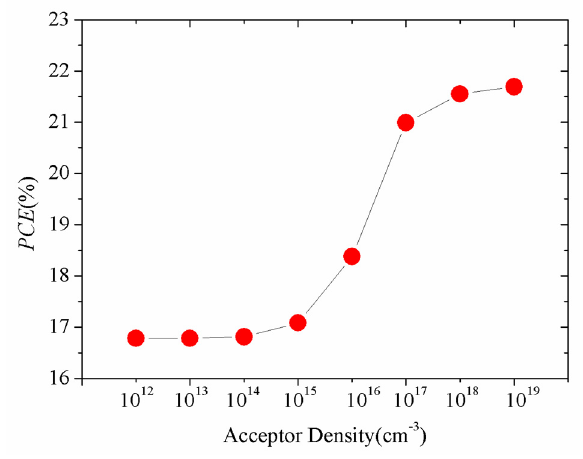
Figure 14. E ff ect of HTL acceptor doping density on Figure 14. Effect of HTL acceptor doping density on PCE. Figure 14. Effect of HTL acceptor doping density on PCE.